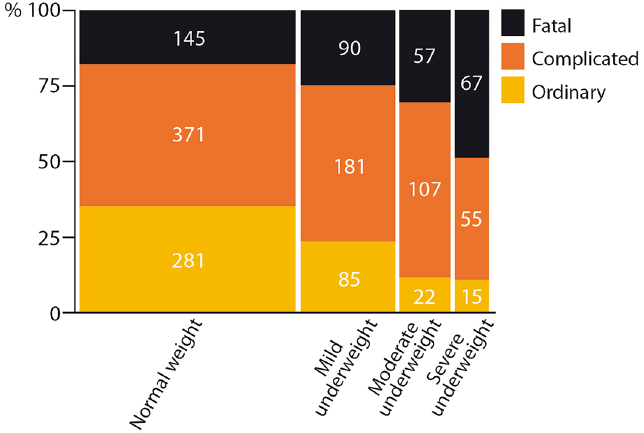
Figure 2. Clinical course according to weight-for-age category in all patients. Ordinary : Daily improvement and diminishing irritability. No seizures after day 3 of treatment. No focal neurological signs at any time. Complicated : Fever (axillary temperature > 37.4 °C), or irritability over 5 days. Seizures after day 3 of treatment, or focal seizures any time. Focal neurological signs at any time. Another focus of infection. Causal micro- organism resistant to the administered antibiotic. Fatal : Death caused by bacterial